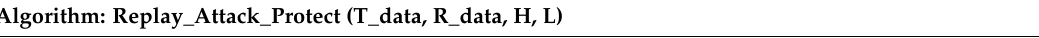
Table 3. Pseudocodes used to protect Replay Attack in the proposed SIF using Zigbee protocol.